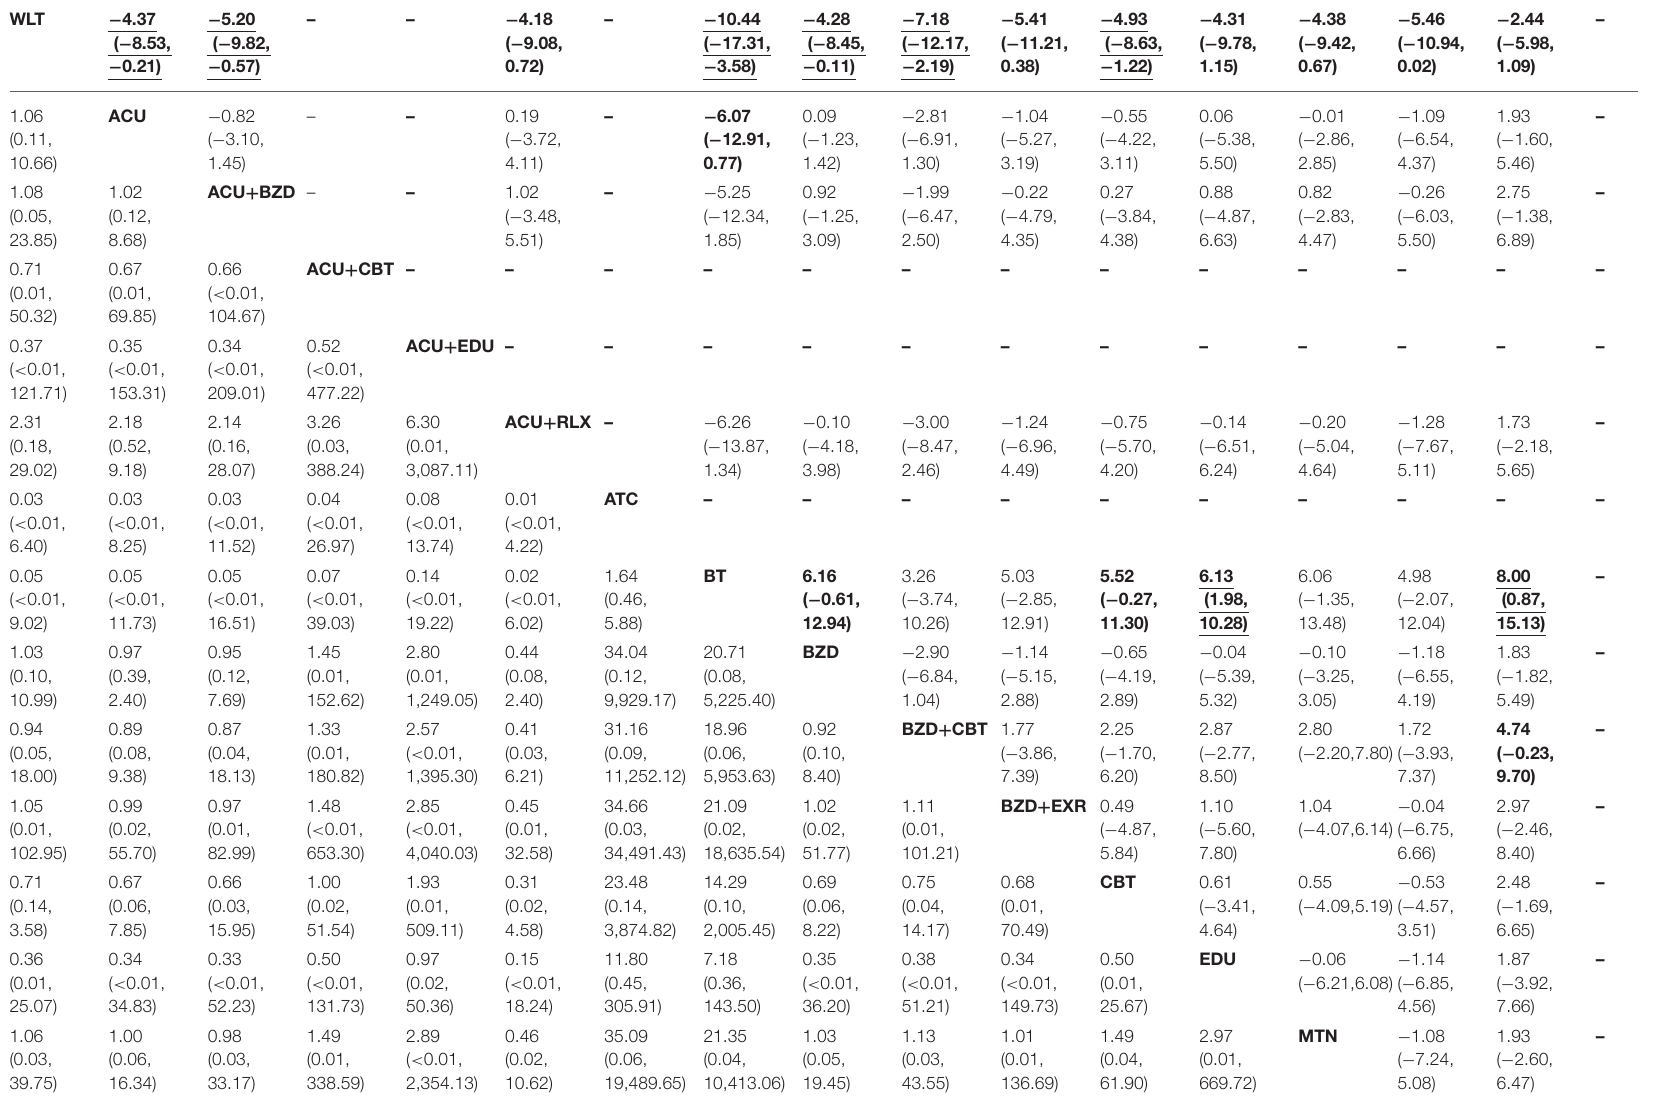
TABLE 2 | Head-to-head comparisons for effectiveness and acceptability of the non-pharmacological interventions. WLT − 4.37 ( − 8.53,